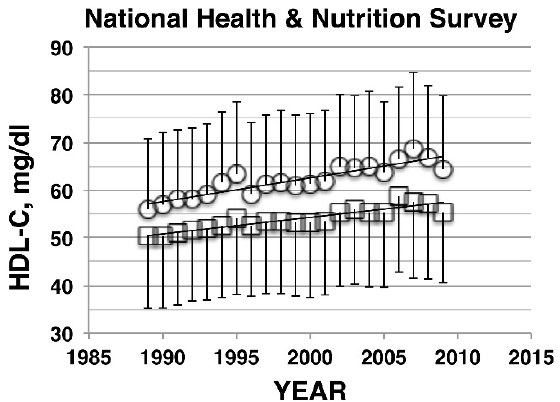
Figure 1. HDL-cholesterol (HDL-C) data in the National Health and Nutrition Survey, mean ± SD, for male (squares) and female (circles). The slopes are 0.35 mg/dL/year and 0.5 mg/dL/year for male and female, respectively, with p <0.001 for both [6].